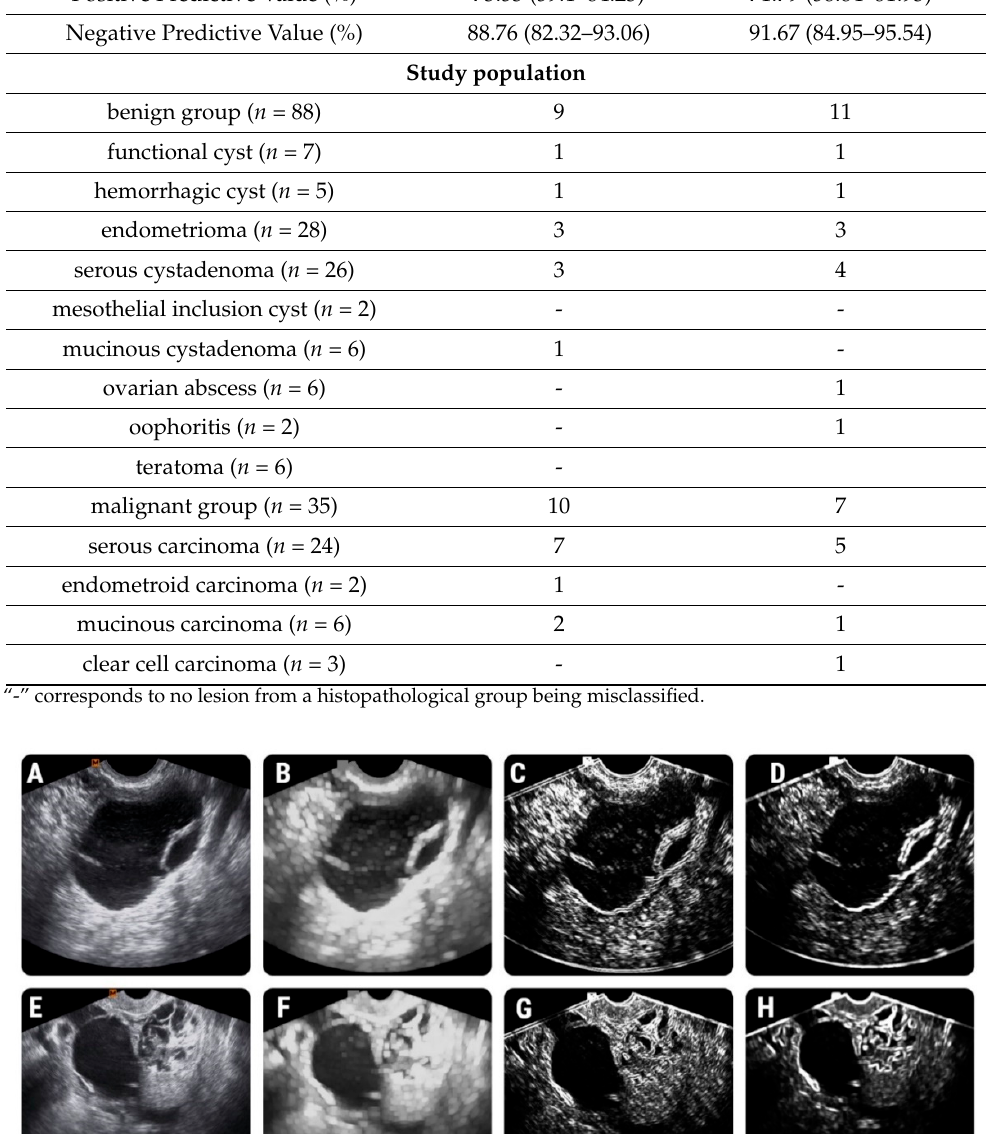
Figure 4. Texture maps that show the distribution of texture features in selected images. ( A ) The ultrasound image of a 34-year-old patient with histologically-proved mucinous cystadenoma; ( B – D ) show the distribution of Perc99, CV5D6SumVarnc, and CV5D6SumOfSqs in image ( A ); ( E ) The ultrasound image of a 67-year-old patient with histologically-proved serous ovarian carcinoma; ( F – H ) show the distribution of Perc99, CV5D6SumVarnc, and CV5D6SumOfSqs in image ( E ).